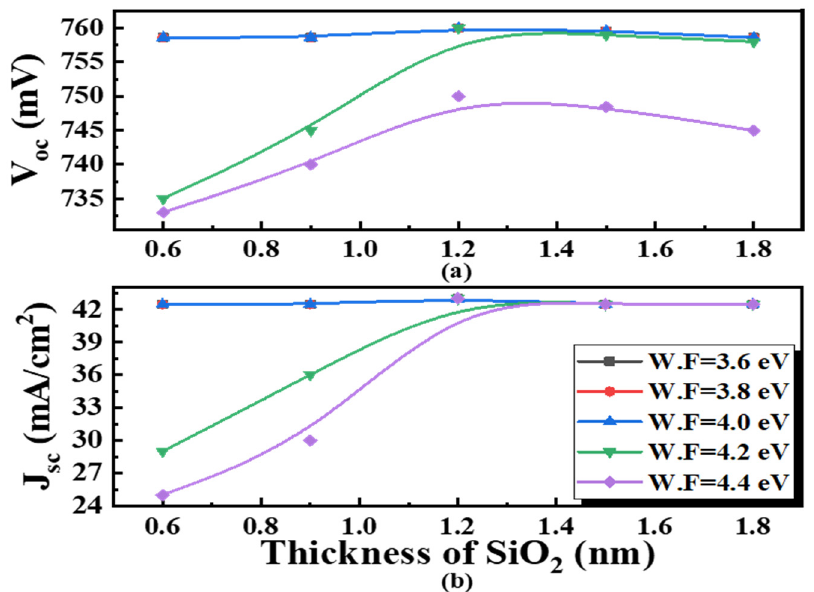
Figure 6. Effect of oxide thickness (0.6 – 1.8 nm) with oxide work function (3.6–4.4 eV) on ( a ) V oc and ( b ) J sc on the TOPCon solar cell. ( b ) J sc on the TOPCon solar